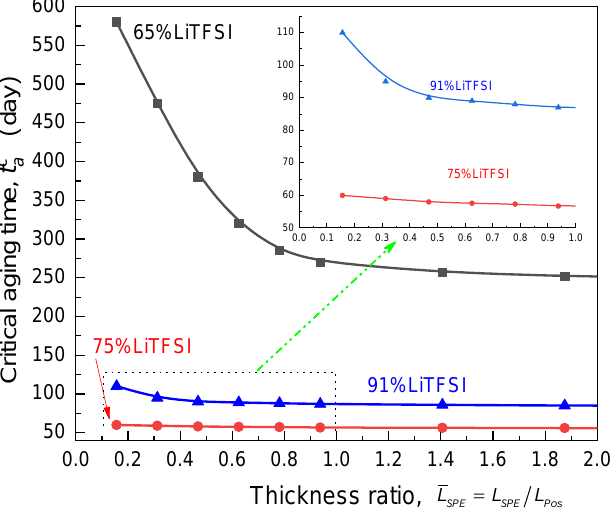
Figure 11. Effect of thickness ratio of the electrolyte relative to the cathode on the critical aging time.